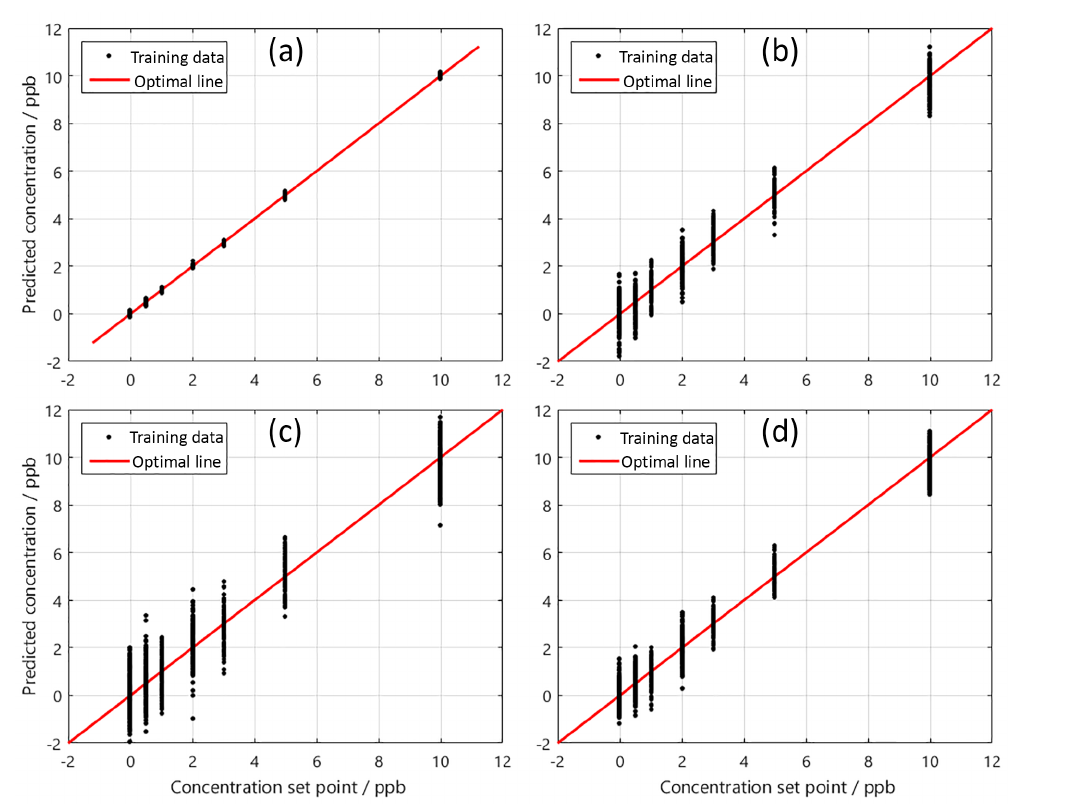
Figure 2. PLSR benzene quantification results for four different background and interferent configurations (Leidinger et al., 2017): (a) ben- zene in pure zero air and with 2ppb of toluene added, at 25 %RH. (b) Benzene in standard air and variation of CO background, 10, 25 and 40%RH. (c) Benzene in standard air and variation of toluene, 10, 25 and 40%RH. (d) Benzene in standard air and variation of toluene and CO, 25 and